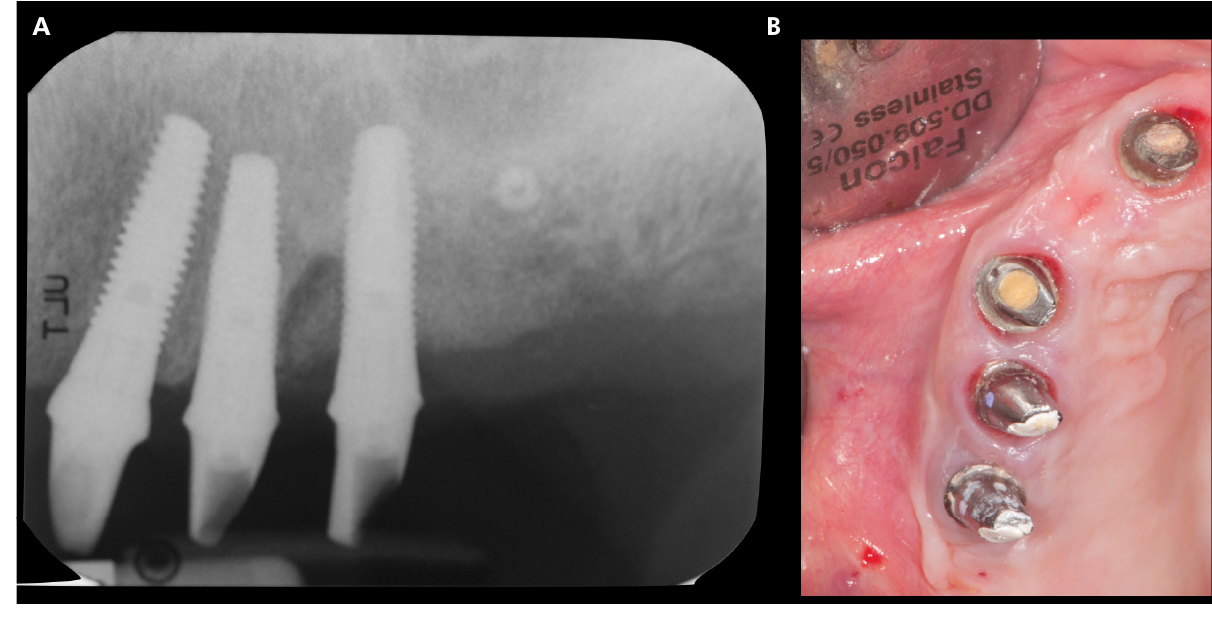
Figure 1. Preoperative radiograph (a) and clinical appearance of the defect (b).